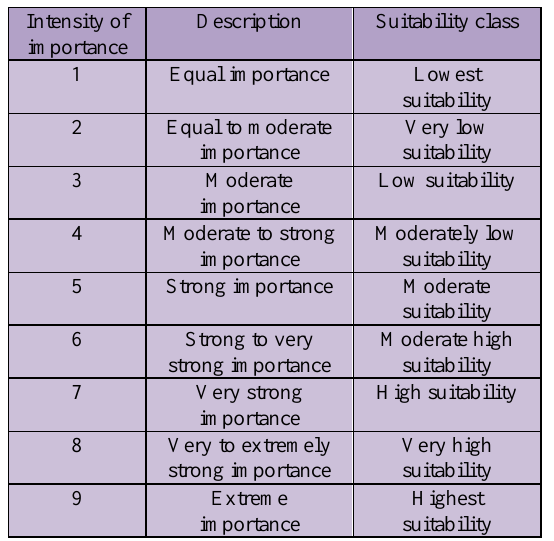
Table 1 : The fundamental scale for factor used, source by Aburas et al. (2015) from Asian Journal of Applied Sciences